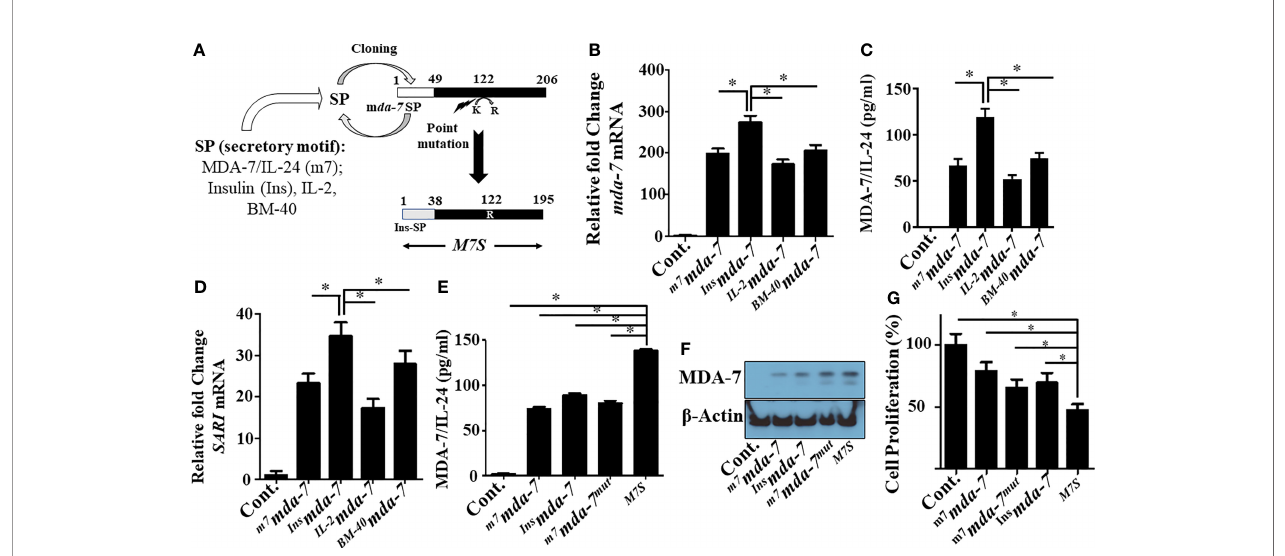
FIGURE 1 | Engineering and primary characterization of a designer cytokine, “ MDA-7/IL-24 Superkine ” (M7S; IL-24S). (A) Schematic illustration of the creation of an “ MDA-7/IL-24 Superkine ” (M7S; IL-24S) protein (Not drawn to scale). The endogenous signal peptide sequence of MDA-7/IL-24 was replaced with a secretory peptide motif from the corresponding proteins (as indicated) to de fi ne secretion capability (tested in panel B – D . An additional point mutation (Lysine to Arginine) was introduced and combined with the Insulin signal peptide (Ins SP ) carrying mda-7 to enhance protein stability. The resulting mutant construct with both changes is called a “ designer cytokine ” . (B) DU-145 cells were transfected with the indicated mutants and the conditioned media (CM) from transfected cells were collected and normalized, based on total protein expression. DU-145 cells were incubated with CM supplemented culture media for 24 hr. and the transcript levels of mda-7/IL-24 were determined with q-PCR. Fold changes of mda-7/IL-24 are maximum in cells treated with CM from Insulin-SP- mda-7 ( Ins mda-7 ) transfected cells. (C) DU-145 cells were incubated with CM isolated from different experimental plasmid-transfected cells as described in Panel (B) Quanti fi cation of expression of secretory MDA- 7/IL-24 protein in the culture media was determined by ELISA. (D) Fold-change in the mRNA transcript level of SARI , a downstream marker of mda-7/IL-24 treatment, in DU-145 cells treated with CM isolated from DU-145 cells transfected with the indicated plasmids. Fold-change of up regulation of SARI (mRNA) is maximum in cells treated with CM from Ins mda-7 transfected cells. (E, F) Expression of MDA-7/IL-24 protein in the CM of DU-145 cells following transfection with the indicated plasmids as determined by ELISA and Western blotting. (G) MTT assays showing inhibition of cellular proliferation in DU-145 cells treated with the CM isolated from DU-145 cells transfected with the indicated plasmids. *Statistical signi fi cance (p <